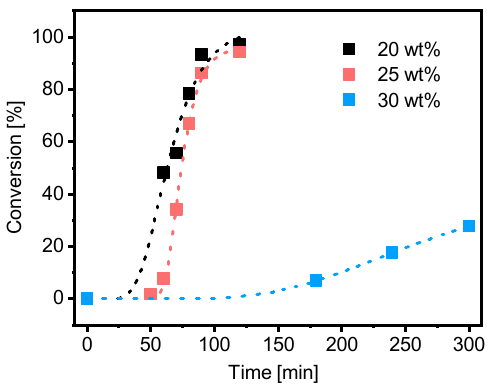
Figure 7. Conversion versus time of the RAFT emulsion polymerization of PMAA 10 - b -PS 9045 with CTA1 and a targeted DP of [Sty]/[CTA] = 400 and a molar ratio of [CTA]/[ACVA] = 5 at 80 °C and a solid concentration of 20, 25 and 30 wt%.